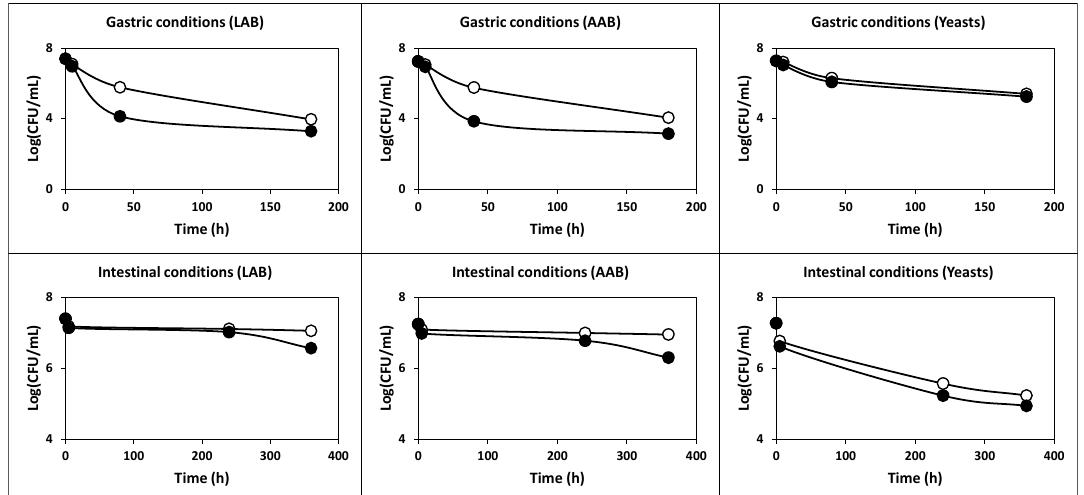
Figure 7. Survival of the populations of LAB, AAB and yeasts under simulated gastric (pH 2.0 + pepsin) and intestinal (pH 8.0 + pancreatin) transit ( black circles ). Controls ( white circles ) consisted of samples at the same pH values without enzymes. The experimental data represent the means of three experiments and two analytical replicates.